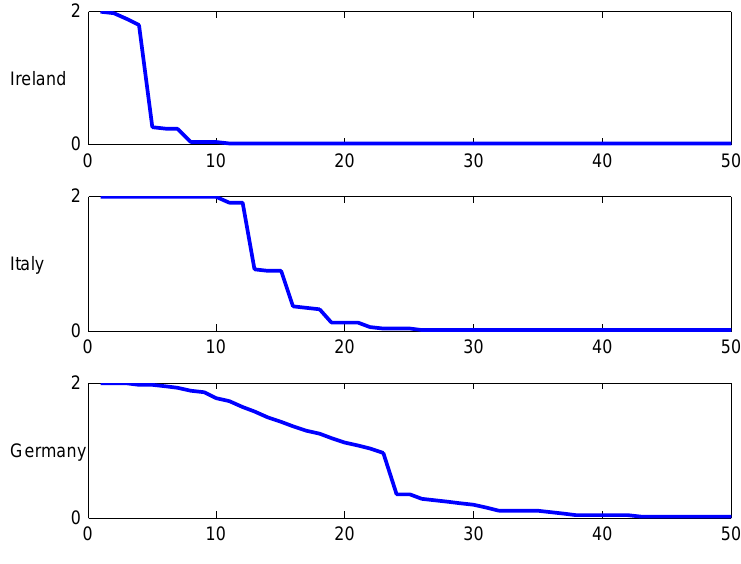
Figure 14. Population averaged convergence rates: population mean 0.05.